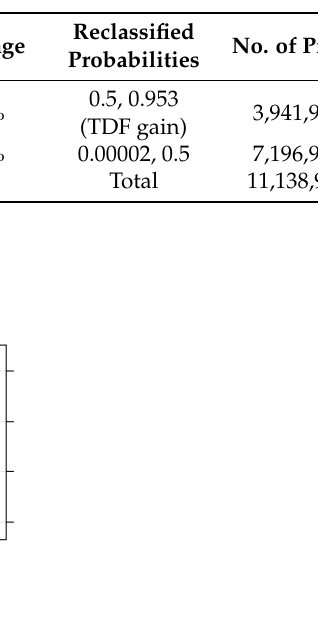
Table A7. Reclassified probabilities of TDF loss and gain using a threshold of 0.5.